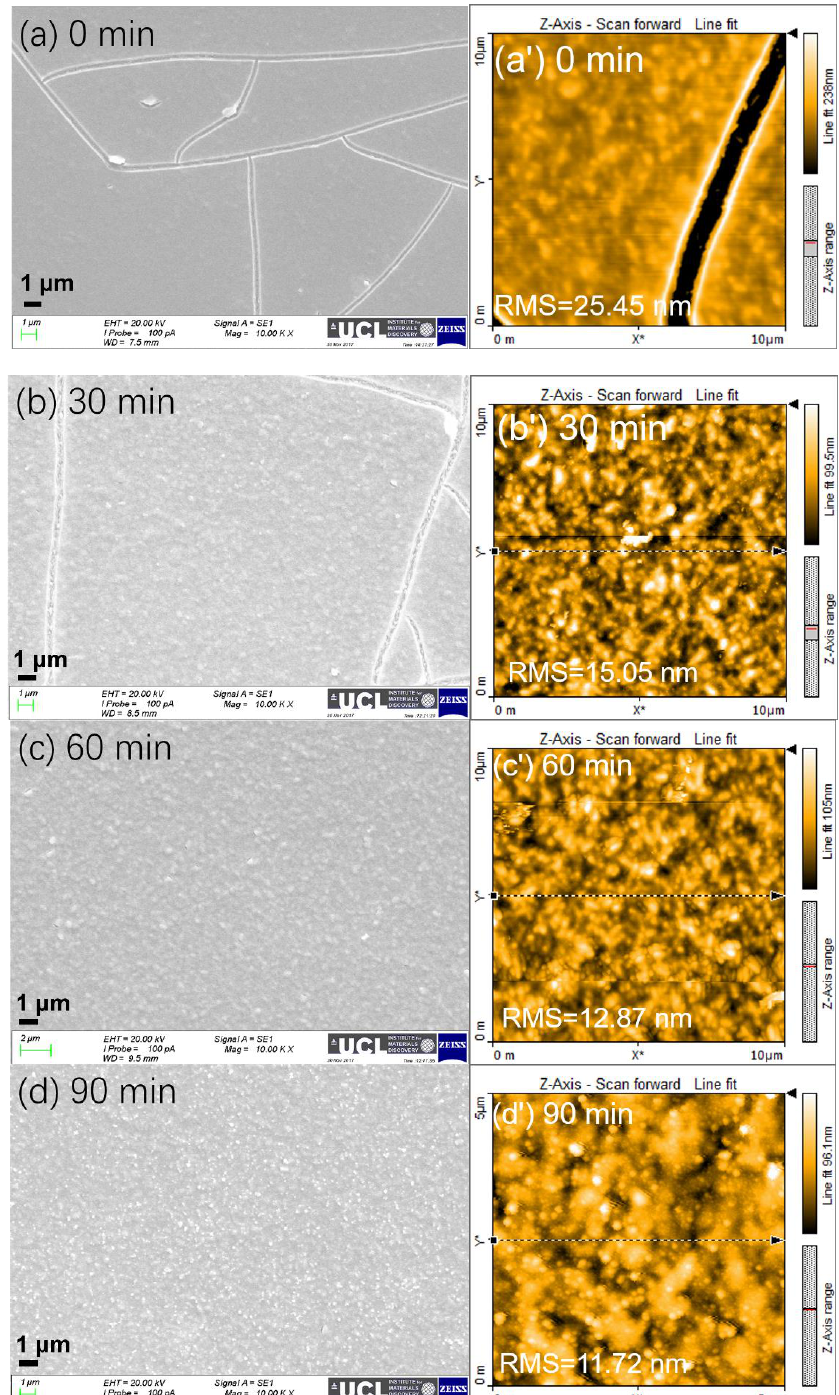
Figure 4. SEM and AFM images of blocking layer TiO2 deposited on after treatment time of TiCl4 for different times varying from 0, 30, 60, to 90 min. a, b, c and d represent SEM images while a’, b’, c’ and d’ denote AFM images of samples pretreated for 0, 30, 60, to 90 min, respectively.